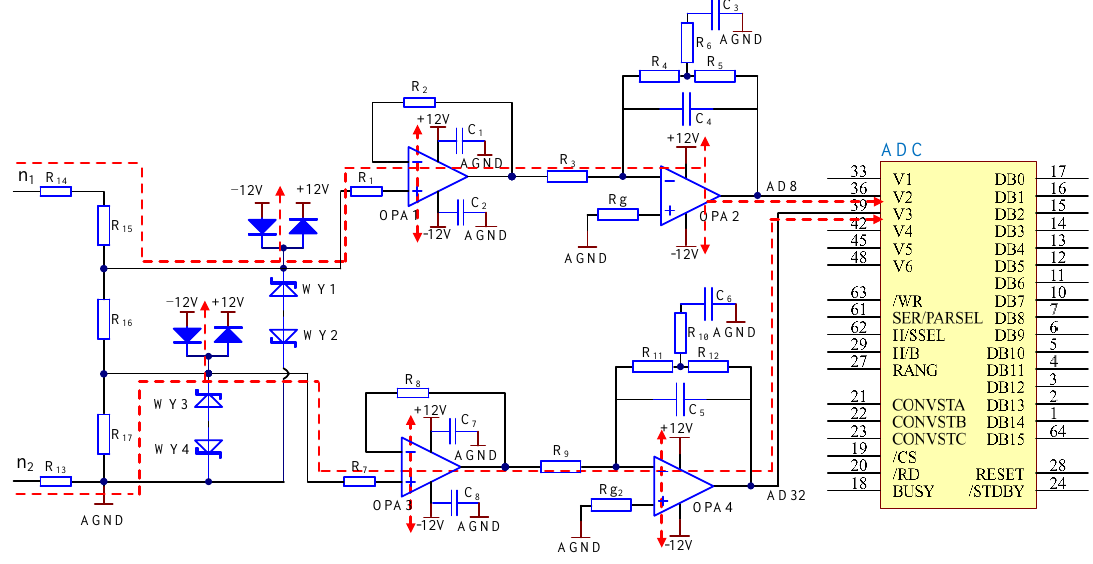
Figure 13. Interference coupling path of an electrical fast transient pulse at signal input.